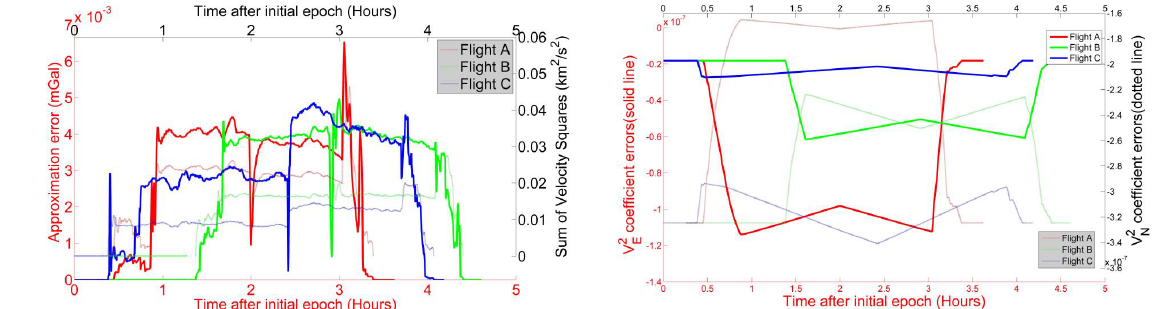
Figure 2. The approximation errors and their associated velocities along the entire selected flights. (The horizontal axes are unified at the corresponding initial epoch of each line.)